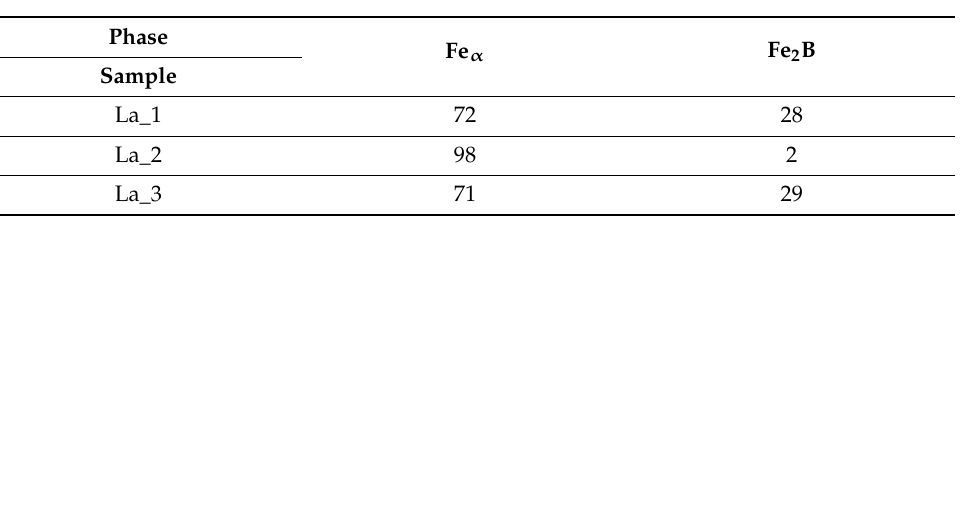
Table 2. Quantitative phase analyses of the main phases present in tested Fe-B-La-Al ingots